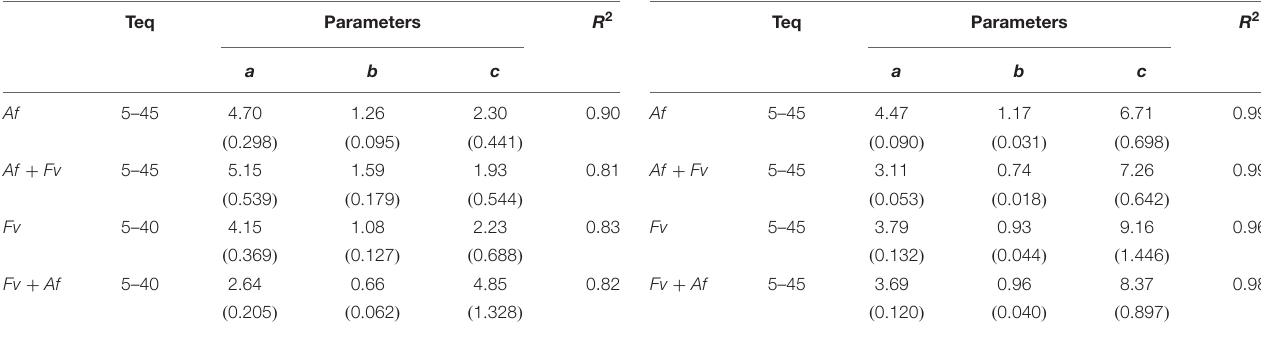
TABLE 3 | Estimated parameters and summary statistics (standard errors of parameters are reported in parenthesis) of non-linear regression analysis (Eq. 1) developed to calculate mycotoxin production rate (aflatoxin B 1 for Af and fumonisin B 1 and B 2 for Fv ) of alone and together fungi as function of temperature ( T